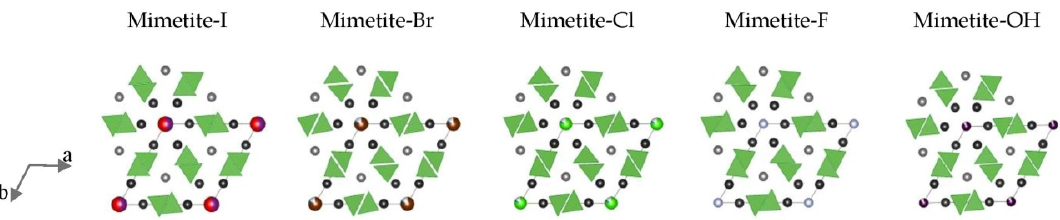
Figure 8. Correlations between metaprism twist angle ϕ and: ( a ) average crystal radius, ( b ) unit-cell parameter a , and ( c ) unit-cell parameter c . Halogenated mimetites from this study are denoted by blue dots, and pyromorphites-F and -Cl reported by White and Dong [2] are denoted by green triangles. All OH-phases are marked by diamonds: mimetite-OH from this study (blue), and pyromorphite-OH reported by White and Dong [2] (green). Average crystal radius as well as the unit-cell parameters a and c increase in the mimetite series F-Cl-Br-I and in the pyromorphite series F-Cl from left to right.